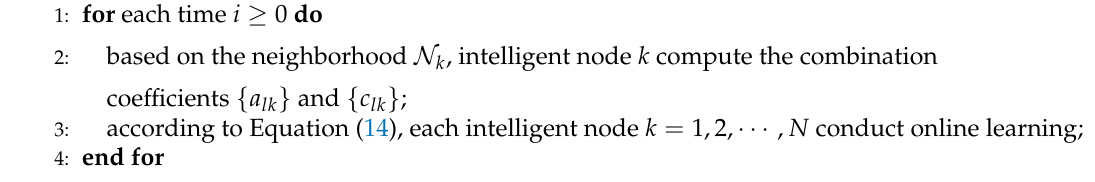
Algorithm 3: Diffusion strategy for distributed learning (ATC).